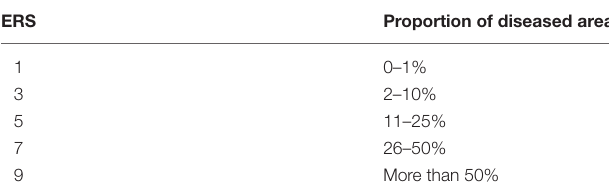
TABLE 2 | Classification of ear disease score.